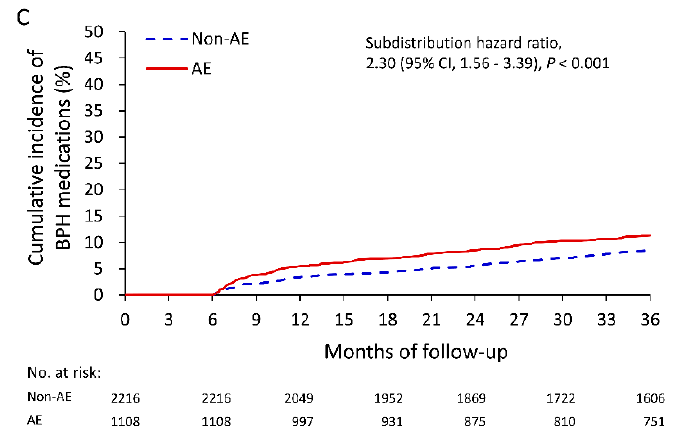
Figure 2. Unadjusted cumulative event rate of all-cause mortality ( A ), cumulative incidence of transurethral resection of the bladder tumor ( B ), and long-term use of medications for treating benign prostatic hyperplasia ( C ) in patients with and without adverse events during the first six-month follow-up in the TURP cohort.